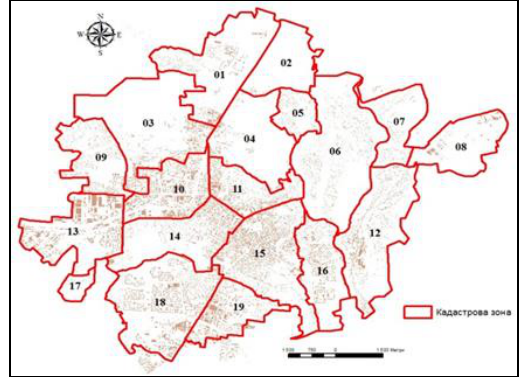
Figure 5. The numbers of the cadastral zones of Poltava city